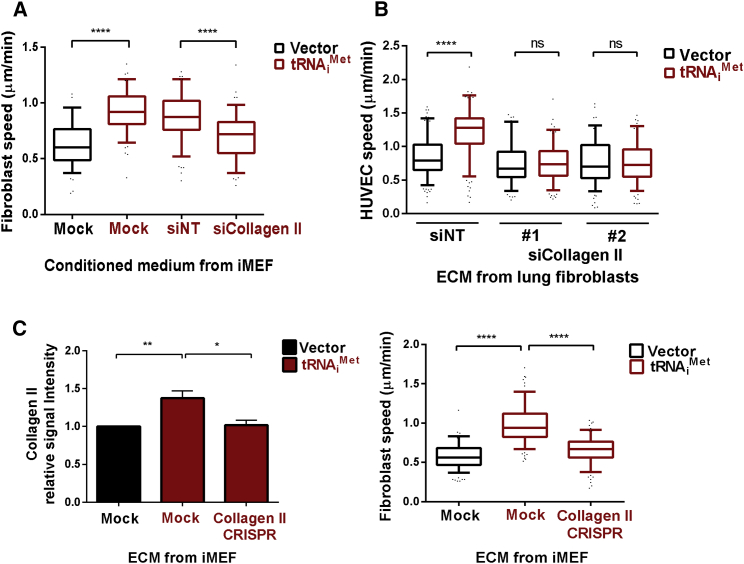
Collagen II Secretion Is Required for tRNAiMet to Drive Production of a Pro-migratory ECM(A) ECM was generated from iMEFs in the presence of conditioned media from iMEF-tRNAiMet cells treated with non-targeting (siNT) or type-II-collagen-specific siRNA (siCollagen II). Migration of immortalized MEFs (iMEFs) on the ECM was recorded by time-lapse microscopy over a 17-hr time course and analyzed using ImageJ. See Figures S6A–S6C for a schematic representation of the protocol for this experiment, the validation of the siRNA, and representative examples of the migration track plots.(B) ECM was generated from primary lung fibroblasts treated with non-targeting (siNT) or type-II-collagen-specific siRNA (siCollagen II). Two independent pools of fibroblasts from 2+tRNAiMet mice were used as indicated. Migration of human umbilical vein endothelial cells (HUVECs) on the ECM was recorded by time-lapse microscopy and analyzed using ImageJ.(C) ECM was generated from iMEF-vector, iMEF-tRNAiMet, and iMEF-tRNAiMet with type II collagen II stable knockdown (iMEF-tRNAiMet Collagen II CRISPR). Incorporation of collagen II into the ECM was assessed by immunostaining using type-II-collagen-specific antibodies, quantified using the Aerius infrared imaging system (LI-COR Biosciences); unpaired t test; ∗p < 0.05; ∗∗p < 0.005. Migration of iMEFs was recorded as previously described. Data represent ECM generated from at least three independent ECM isolations, tracking the migration of at least 40 iMEFs in each replicate. Box and whisker plot represents 5–95 percentile; Kruskal-Wallis test; ∗∗∗∗p < 0.0001; ns, not significant. See Figures S6D–S6F for a schematic representation of the protocol for this experiment, the validation of the CRISPR, and representative examples of the migration track plots.